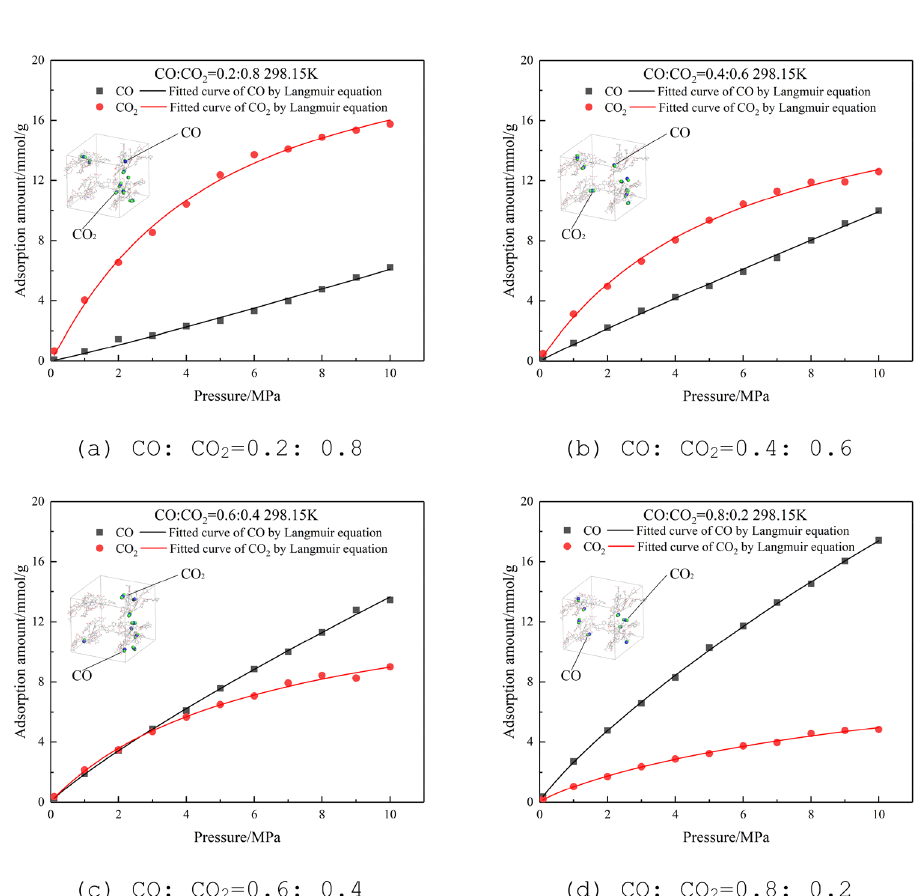
Figure 6. Adsorption isotherms of CO and CO 2 at different molar ratios at 298.15